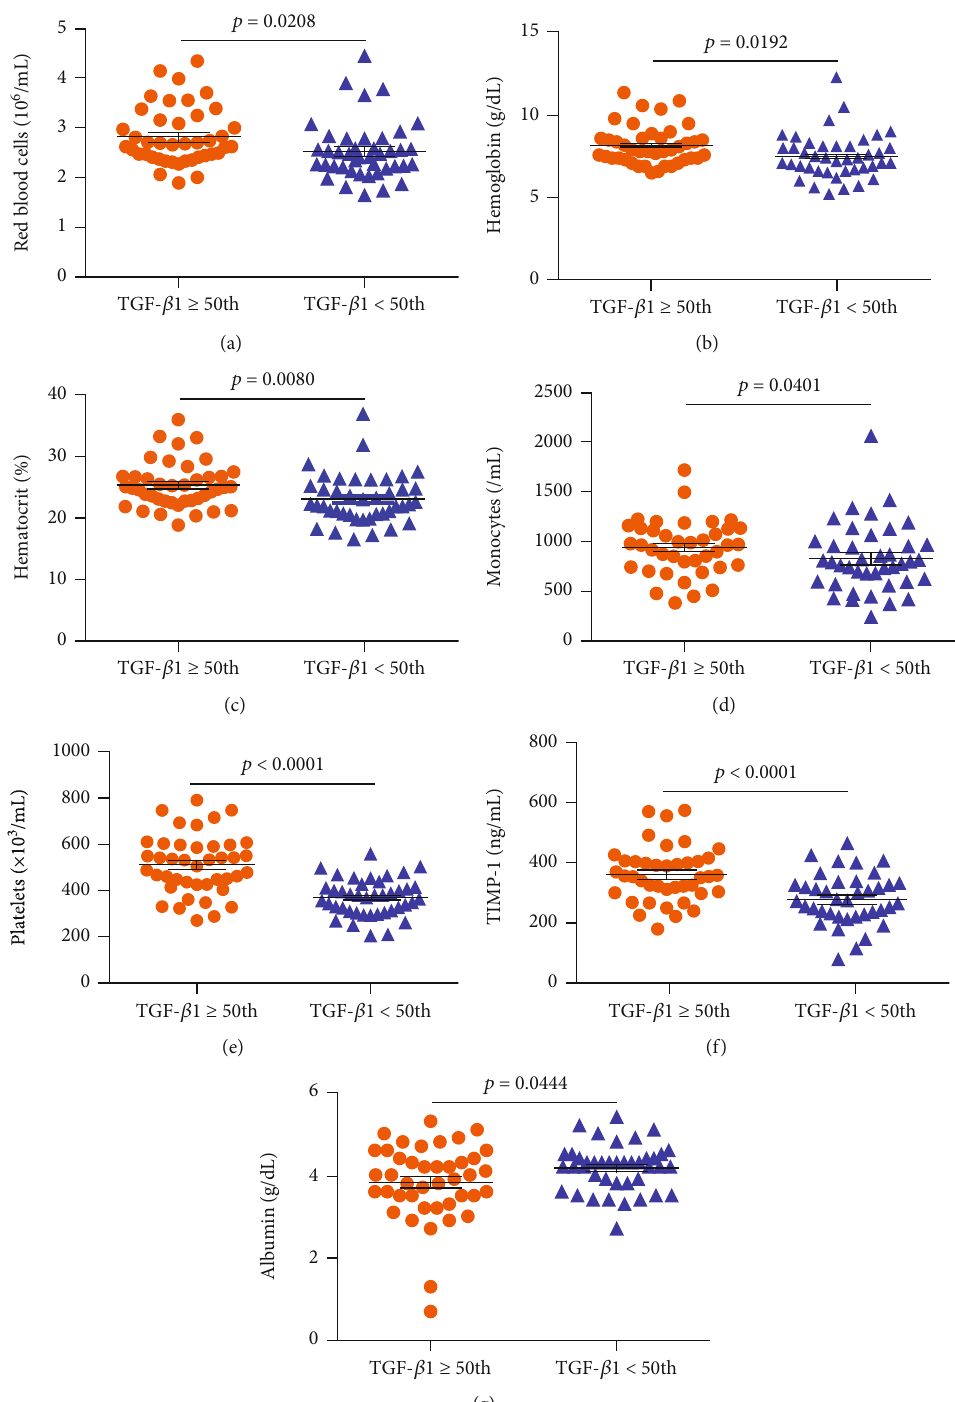
Figure 3: Associations between TGF- β 1 levels and laboratory biomarkers as well as the glycoprotein TIMP-1 in individuals with HbSS. Individuals with TGF- β 1 levels above the median ( TGF ‐ β 1 ≥ 72 : 29 ) exhibited increased (a) RBC counts, (b) hemoglobin levels, (c) hematocrit, (d) monocyte counts, (e) platelet counts, and (f) TIMP-1 levels, as well as (g) decreased albumin levels. All p values were obtained by the Mann – Whitney U test, except for TIMP-1 and platelet counts, for which the independent t -test was